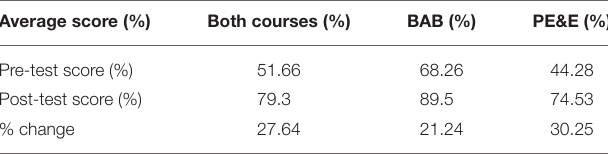
TABLE 3 | Knowledge score improvement per HMS course observed as % change in